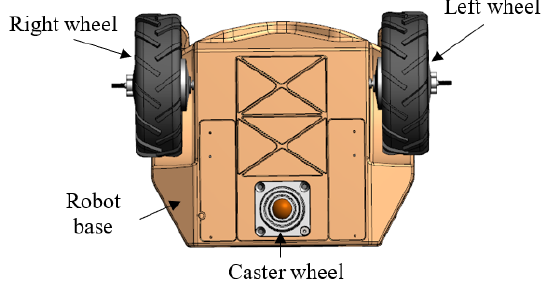
Figure 22. Robot mechanical